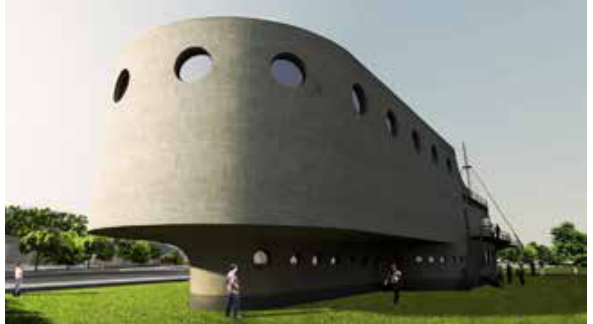
Figure 10. Photorealistic rendering of the 'Casa del Marinaretto'. Human-eye perspective view by F.